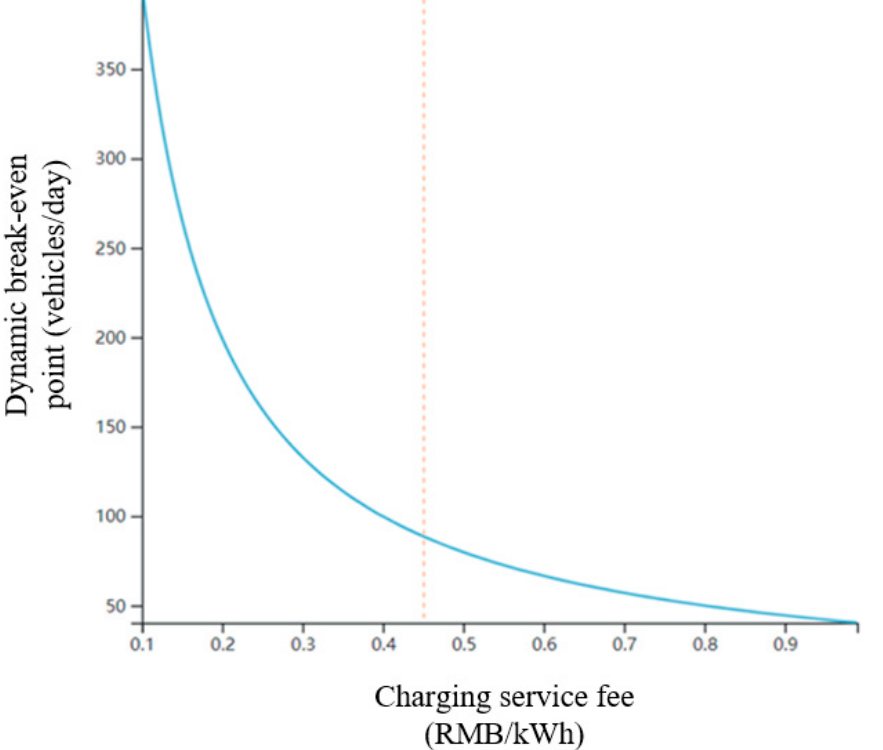
Figure 7. Sensitivity analysis of charging difference between different power purchases. Table 3. Example parameter